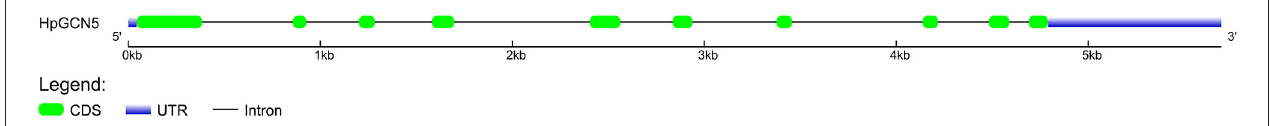
FIGURE 1 | The schematic diagram of HpGCN5 gene structure, which was predicted by aligning with the corresponding genome sequence.